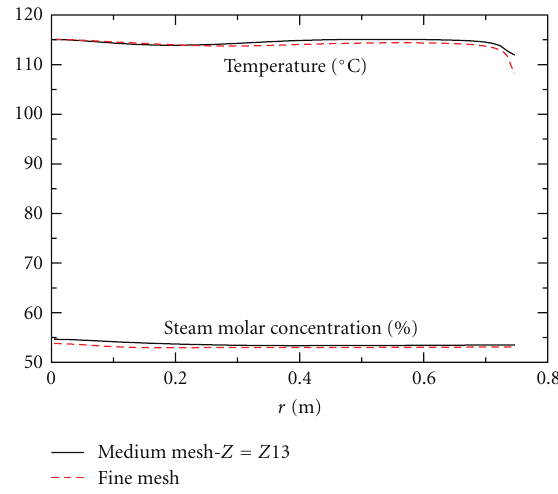
Figure 3: Evolution of the relative pressure during the whole transient.